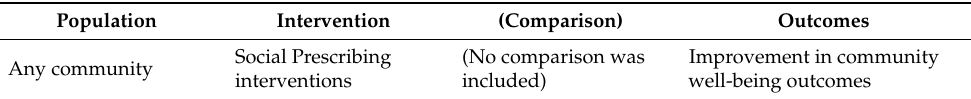
Table A1. Patient/Problem or Population, Intervention, Compartor and Outcome(S) (PICO) frame- work for mixed methods search strategy.